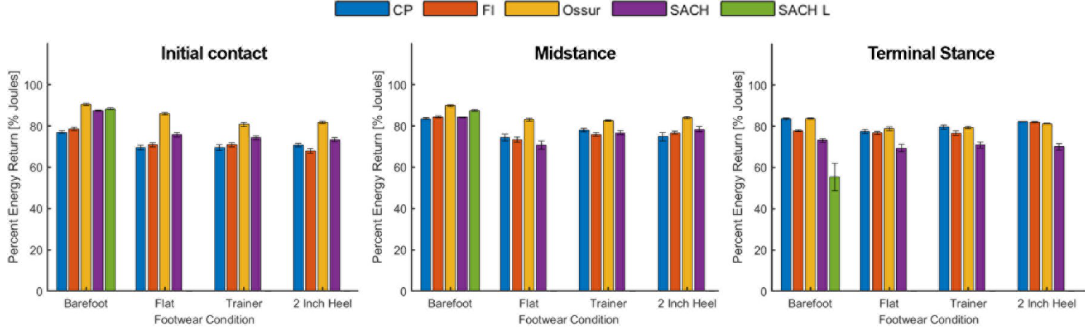
Fig 5. Percent energy return of each prosthesis-footwear combination at initial contact, midstance, and terminal stance loading. CP = College Park; FI = Freedom Innovations; SACH L = barefoot condition with L-block. Error bars denote 95% confidence interval.